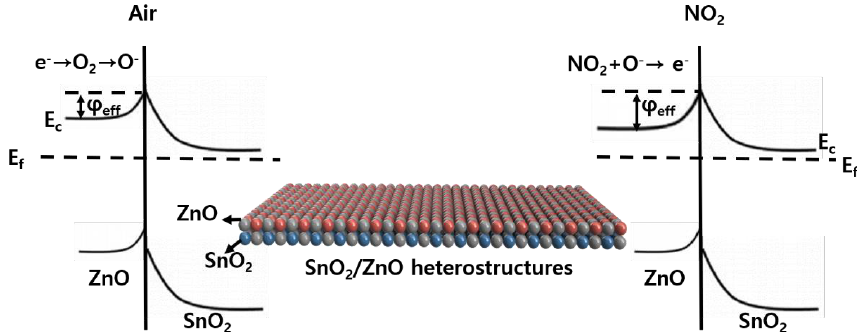
Figure 7. Schematic for energy band diagrams of SnO 2 /ZnO heterostructures in dry air and NO 2 . These results exhibited that SnO 2 /ZnO heterostructures have better gas response compared to their mono counterparts. The improvement in gas response for SnO 2 /ZnO heterostructures can be credited to subsequent features. At first, the surface of SnO 2 /ZnO heterostructures leads to both oxides being highly available for adsorption of the O 2 species, resulting in the creation of a depletion layer onto the surface. Thus, synergetic effects of the oxides perhaps donate the improvement of the gas response in comparison to their mono counterparts. Then, work functions of SnO 2 and ZnO that have stated 4.9 eV and 5.2 eV, respectively, results in the formation of heterojunctions among SnO 2 and ZnO [26]. Shown in Figure 7, is the schematic of energy band diagrams of the SnO 2 /ZnO heterojunction in dry air and NO 2 gas. The flow of electrons form SnO 2 to ZnO till the fermi levels (FE) are balanced. This generates an e - depletion layer onto the ZnO and bend SnO 2 energy band that results in a change in electrical resistance of SnO 2 /ZnO heterostructures. As a sensor was exposed to NO 2 gas at the optimal operating temperature, trapped e - were sent back to the CB of SnO 2 /ZnO heterostructures because of the reaction between adsorbed O 2 species and NO 2 molecules. Therefore, electrical resistance of SnO 2 /ZnO heterostructures was highly increased resulting in an enhanced gas response.